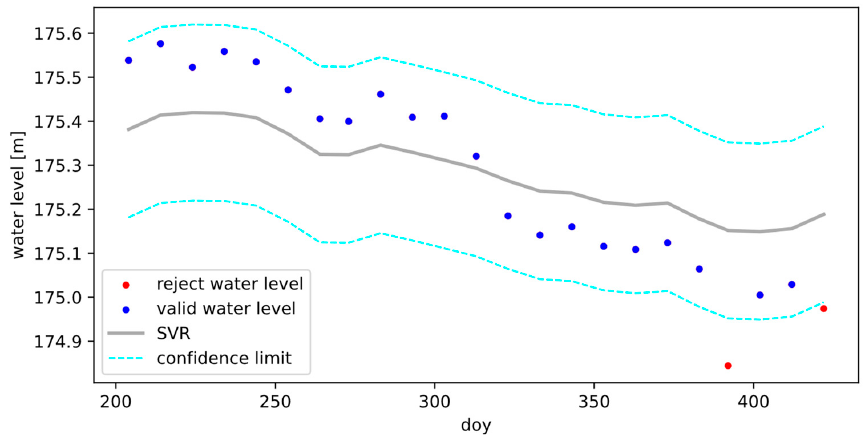
Figure 4. Example of an applied SVR on the time series of 9087068 station. The result shows valid (blue) and rejected (red) water levels. The confidence limit is the cyan dotted line.